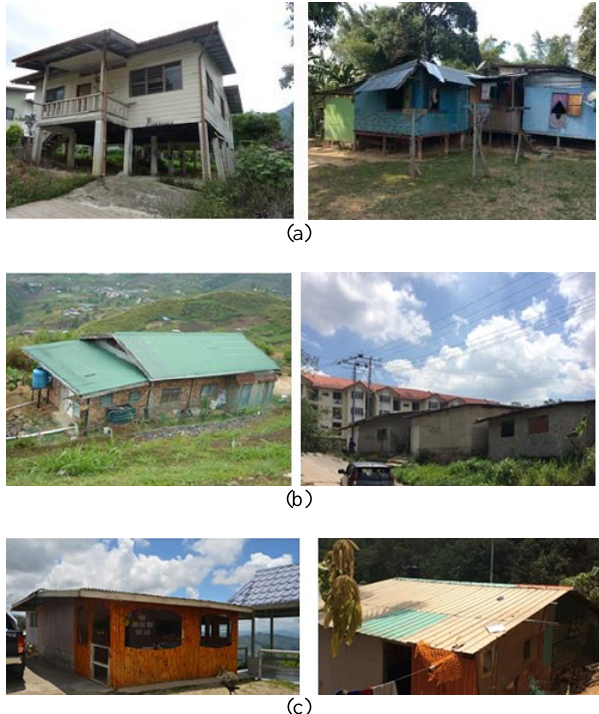
Figure 4. Examples for poor wood/zinc/cement-board building with pillar (a), Poor single storey confined brick masonry building (b) and poor single storey wood/zinc/cement-board building (c) for Kundasang (left) and Kota Kinabalu (right) respectively Each building and road construction material type was crossed with different types of landslides. The vulnerability value for building construction materials is determined based on the damage value as shown in Table 1. The damage level is divided into 5 levels i.e. 1) negligible damage, 2) slightly damage, 3) significantly damage, 4) severely damage and 5) very severe damage. Based on the experience of the experts and damage description, each empty space located in the vulnerability matrix was assigned with the vulnerability value (between 0.0 and 1.0). Roads in Kundasang and Kota Kinabalu are classified into 5 classes, namely 1) highway (well-maintained paved road), 2) federal road (paved road), 3) state road (paved road), 4) rural road (poorly paved road) and 5) unpaved road. The road classes were paired with the above-mentioned types of landslide. Table 2 defines the typical level physical impacts or damages that occurred on road. The damages on the road are classified into 5 groups similar with